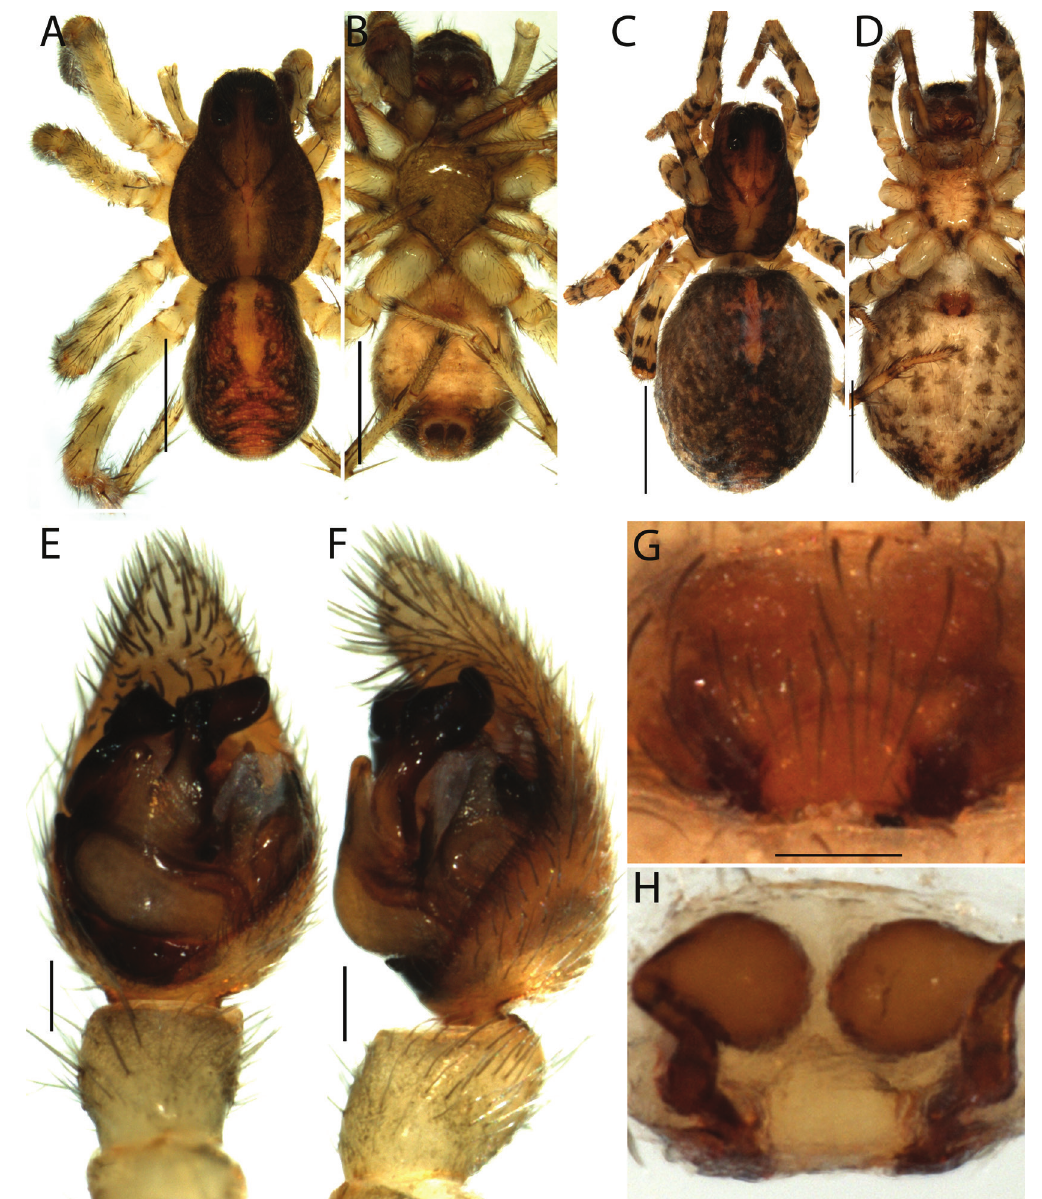
Figure 32. Artoria mungo sp. n., male holotype (AM KS12773), female paratype (AM KS127697): A , male habitus, dorsal view; B , male habitus, ventral view; C , female habitus, dorsal view; D , female habitus, ventral view; E, male pedipalp, ventral view; F , male pedipalp, retrolateral view; G , epigyne, ventral view; H , epigyne, dorsal view. Scale bars: habitus 1.0 mm; pedipalp, epigyne 0.1